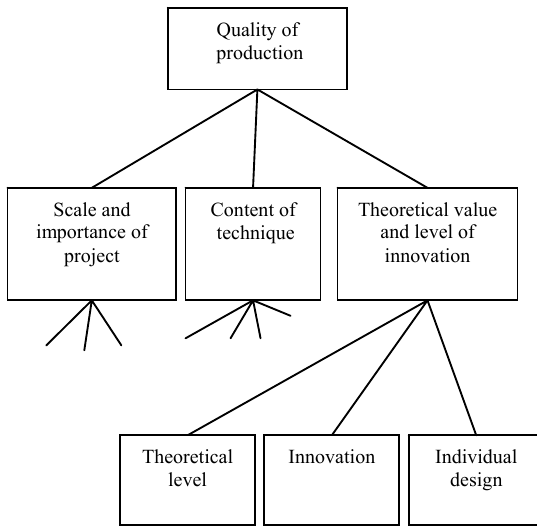
Fig. 2. The hierarchical structure for quality of production in “R&D projects evaluation